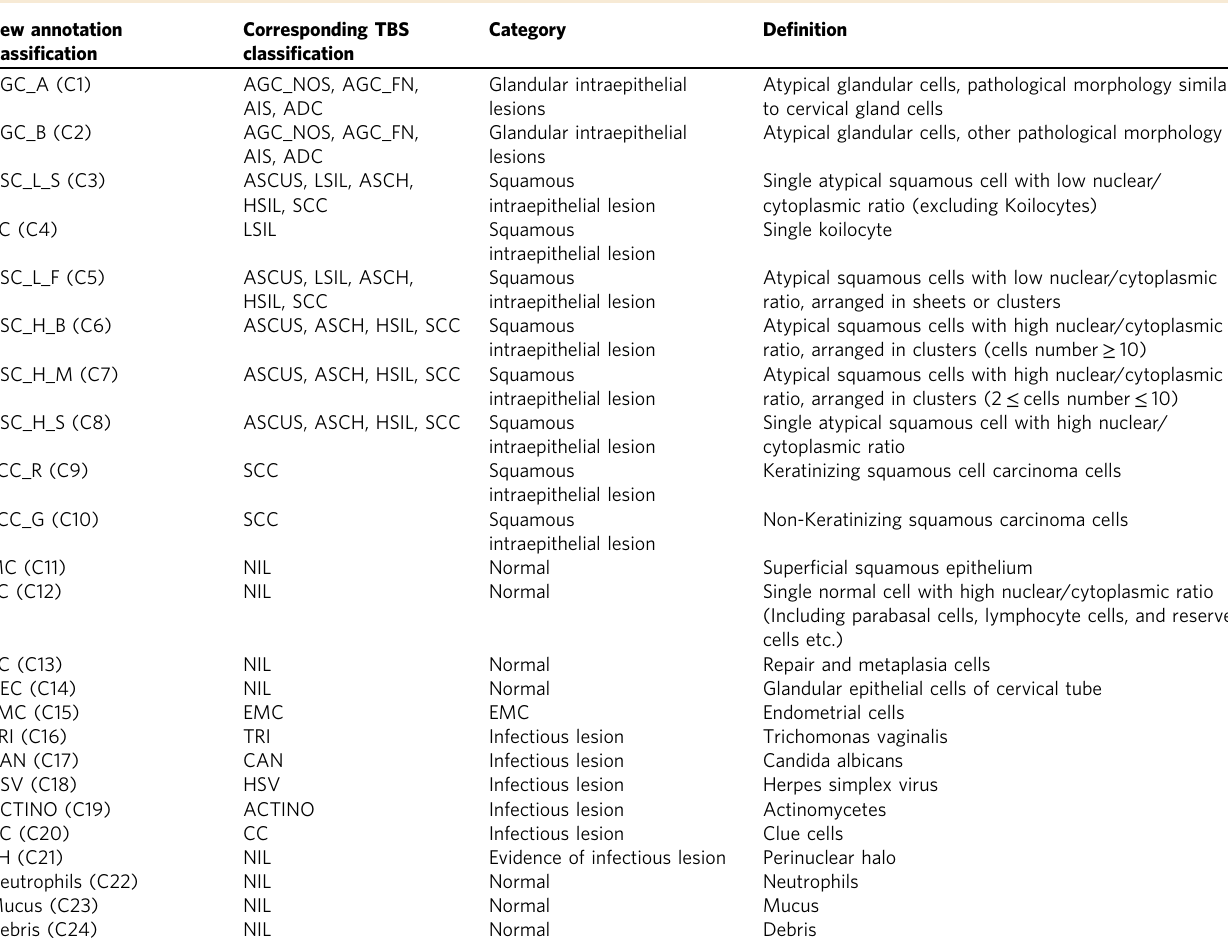
Table 1 Corresponding relationship between new annotation classi fi cation and TBS classi fi cation. New annotation classi fi